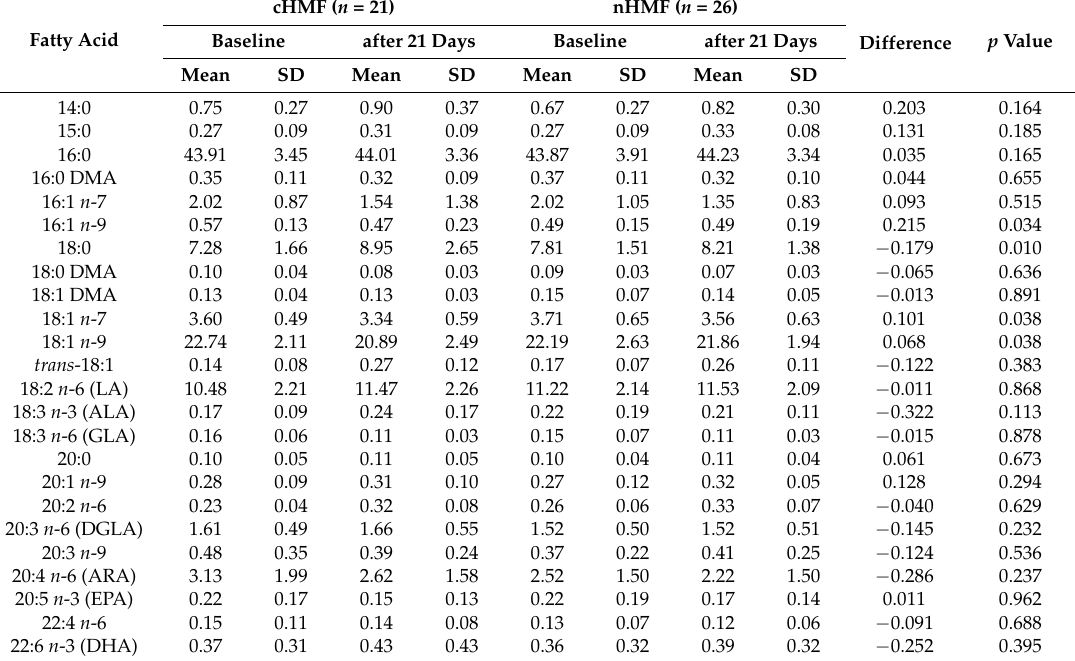
Table 6. Fatty acid profile (g/100 g of fatty acids) of red blood cell phosphatidylcholine (RBC PC) in preterm infants receiving human milk fortified with a control (cHMF) or with a new human milk fortifier (nHMF), before and after 21 days of treatment. Estimations of the treatment effect nHMF/cHMF (Difference) and the two-sided p -value are given for each fatty acid analysed in the different lipid